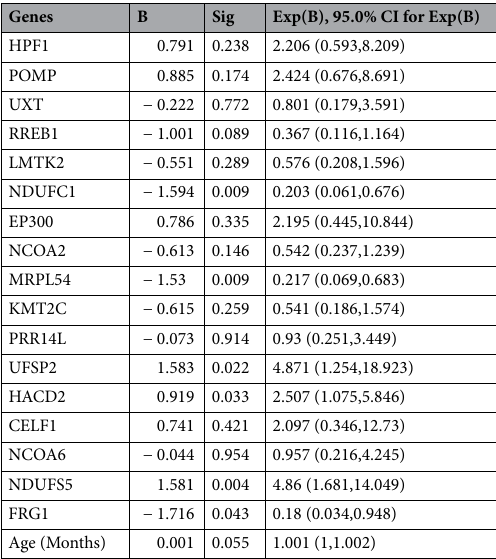
Table 3. Covariates present in multivariate Cox regression model in liver cancer patients.